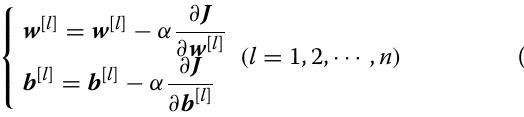
where n is the amount of layers, l represents that the variables belongs to the l − th layer, w [ l ] is the parame- ters matrix and b [ l ] is the bias; a [ l ] is the output matrix of each layer, g is the suitable activation function. Therefore, the neurons of each layer are computed at the same time. The estimated value would be obtained through a series computation of hidden layers. Then, the stochastic gradi- ent descent method which is shown in the Formula (3) is applied for the back propagation to adapt the parameters so that the accuracy becomes better [43, 44].